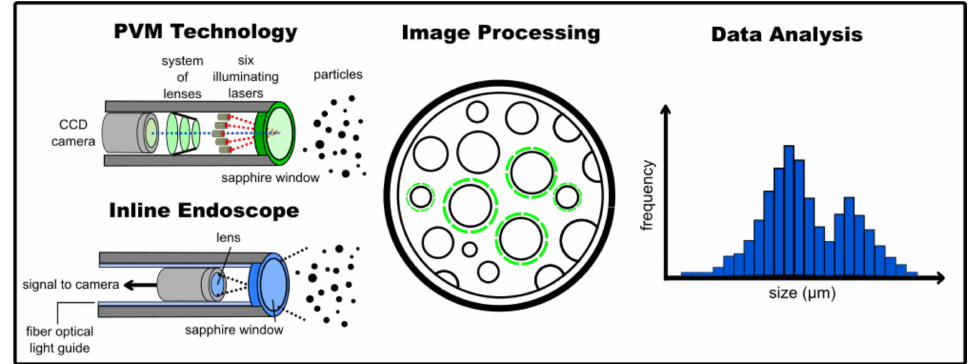
Figure 9. Inline microscopy with image analysis. The sensor setup is shown on the left for a particle vision microscope with inline endoscope. Image processing is shown in the middle, leading to the size distribution shown on the